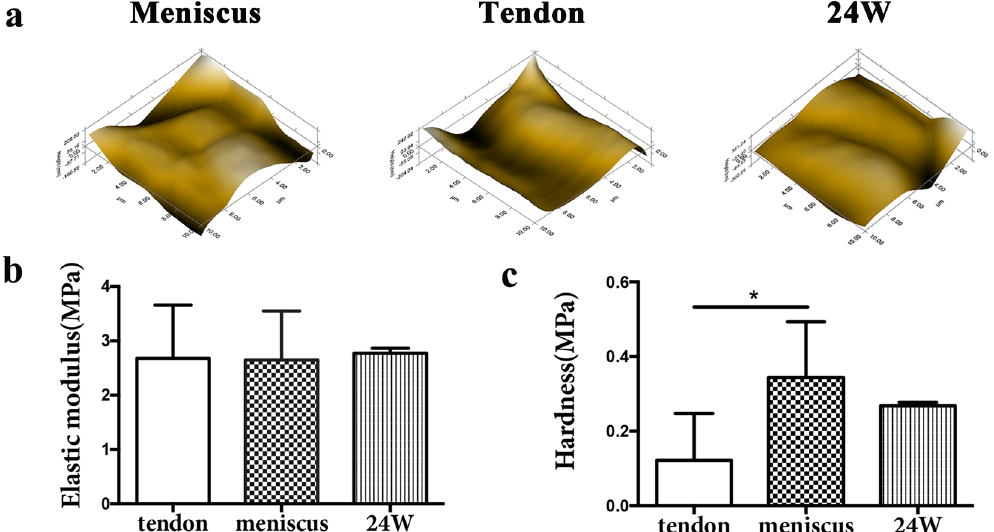
Figure 7. Biomechanical tests of native meniscus, native tendon and regenerated meniscus at 24 weeks post- operative of transplantation group. ( a ) Microscopic geomorphology of the surface of tendon and the femoral condylar contact surface of meniscus and regenerated meniscus was acquired during nanoindentation. ( b ) and ( c ) The biomechanical properties of each tissue were calculated with the biomechanical curves: ( b ) Elastic modulus; ( c ) Hardness (n = 5, * p <